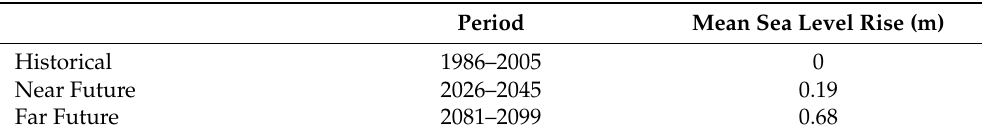
Table 1. The additional rise in mean sea level for historical (data retrieved from [12]), near future and far future periods (data retrieved from [87]).